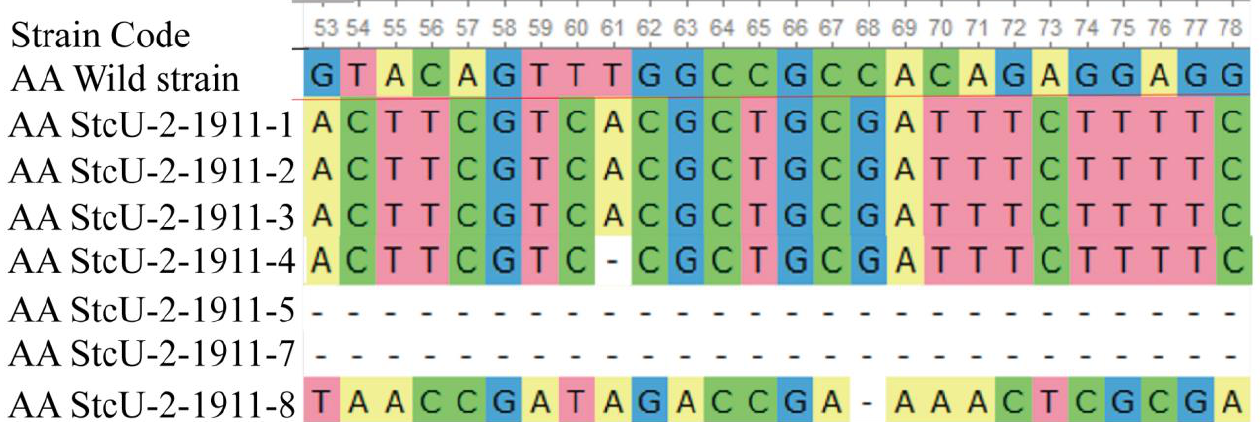
Ascosphaera apis ( A. apis ) wild-strain protospacer sequence and PAM sequence. AAStcU-2-1911-1,